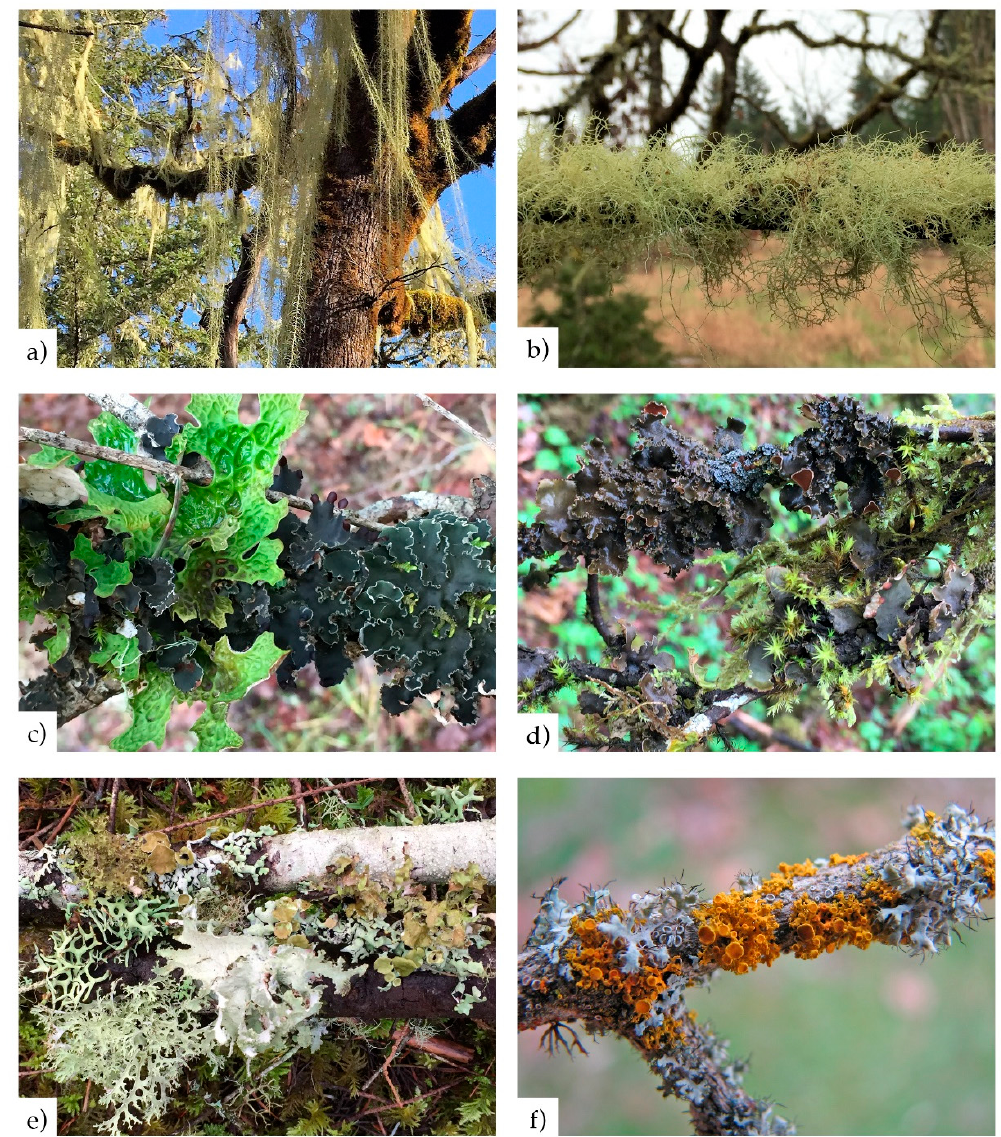
Figure 2. Epiphytic macrolichens exemplifying ( a ) pendant forage lichens, ( b ) shrubby forage lichens, ( c ) large cyanobacterial lichens (cyanolichens), ( d ) small to medium cyanolichens, ( e ) medium to large matrix lichens, and ( f ) small matrix lichens. Near Philomath, western Oregon. Photo credit: ( f ) Jim Riley.